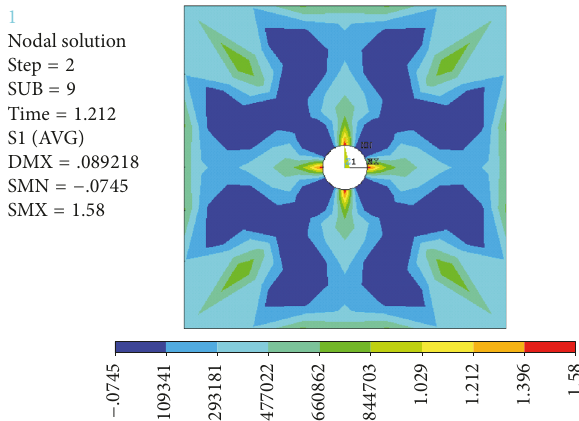
Figure 31: Principal tensile stress on the concrete specimen pre- stressed under a load of 10MPa when the displacement resulting from corrosion-induced expansion reaches 0.031 mm.